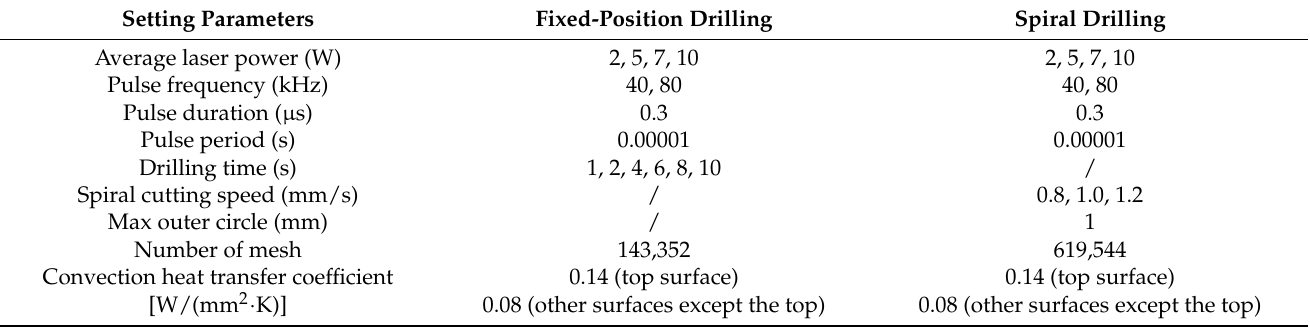
Table 3. Simulation parameters of personal computer (PC).